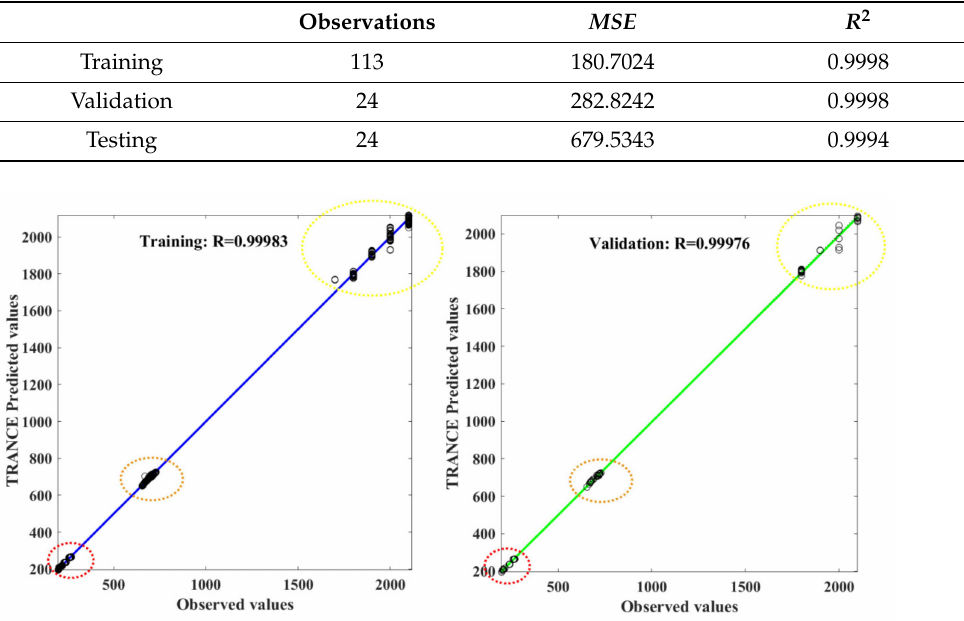
Figure 10. The correlation coefficient for three threat zone prediction values from the TRANCE model in training and validation.